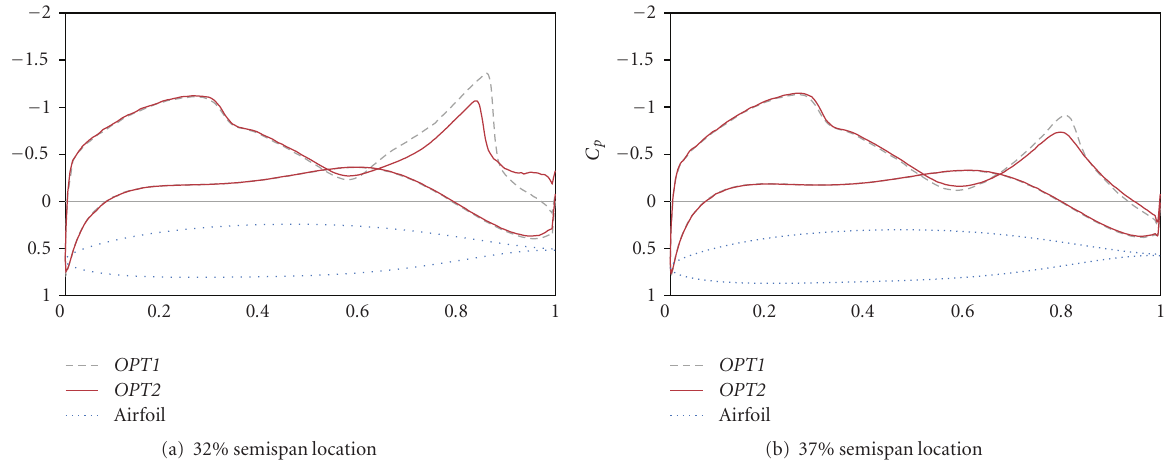
Figure 19: Comparison of C p distribution (black line: OPT1 , red line: OPT2 ).